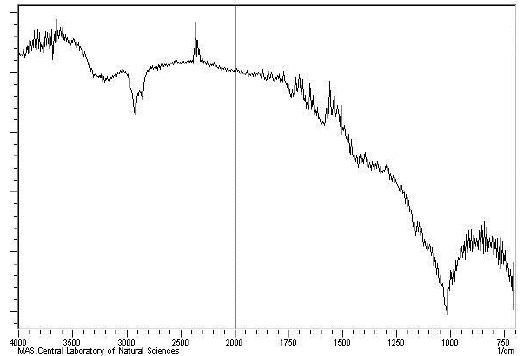
Figure 2. After treatment of Multi walled carbon nanotube with sulfuric acid and hydrogen peroxide by IR spectroscopy